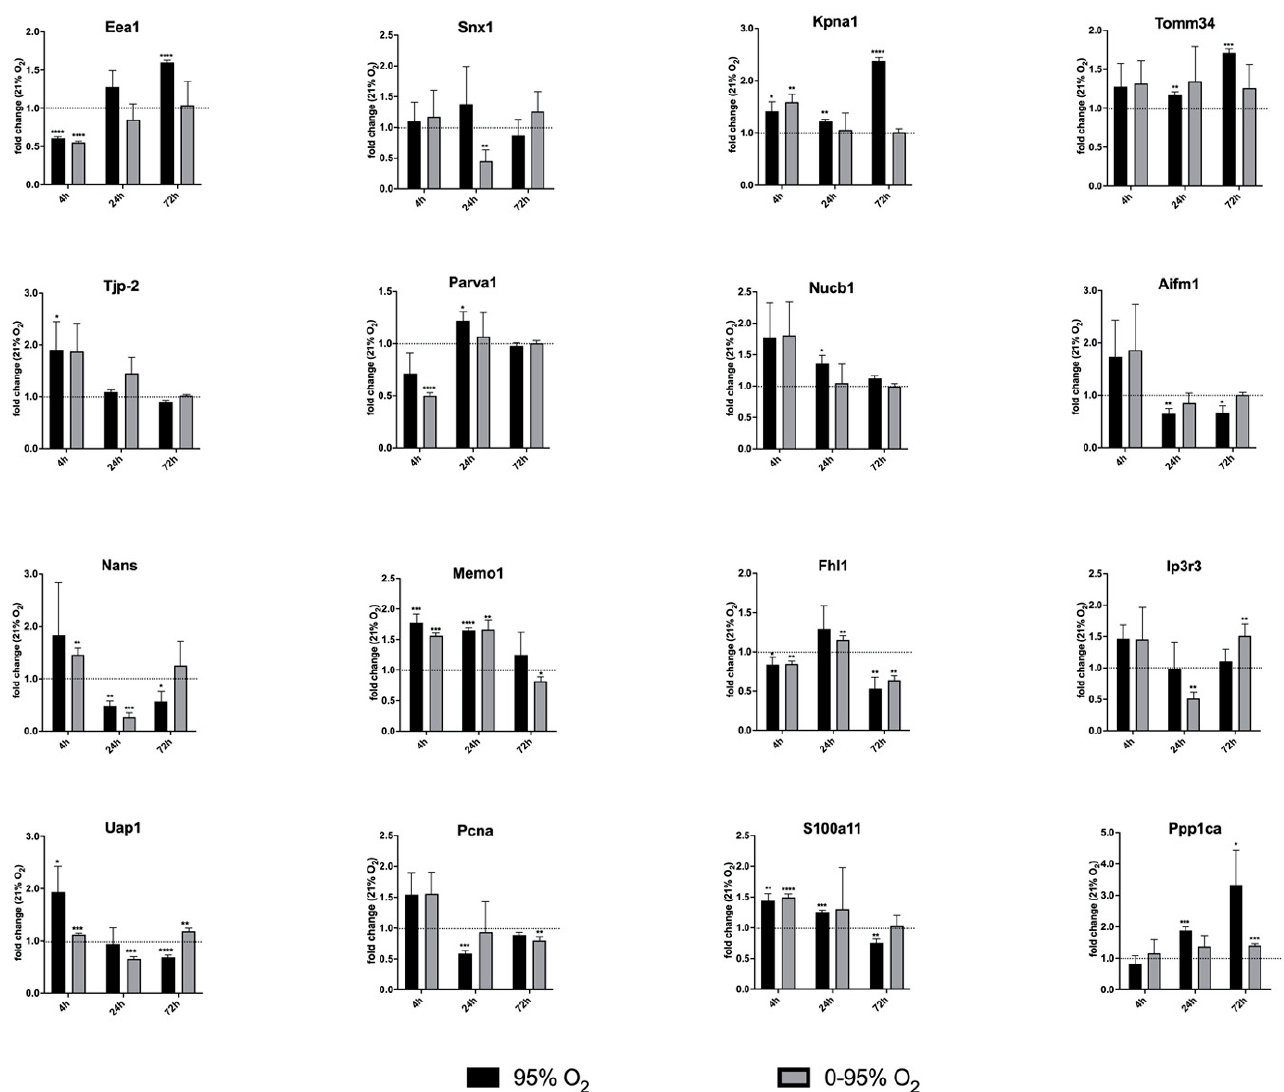
Figure 5. Expression of mRNA levels of selected DEPs as analyzed by qRT-PCR. The mRNAs of the following DEPs as identified from proteomic analysis were quantified: Eea1 (Early Endosomal Antigen-1), Snx1 (Sorting Nexin-1), Kpna1 (importin- α 1), Tomm34 (Translocase of Outer